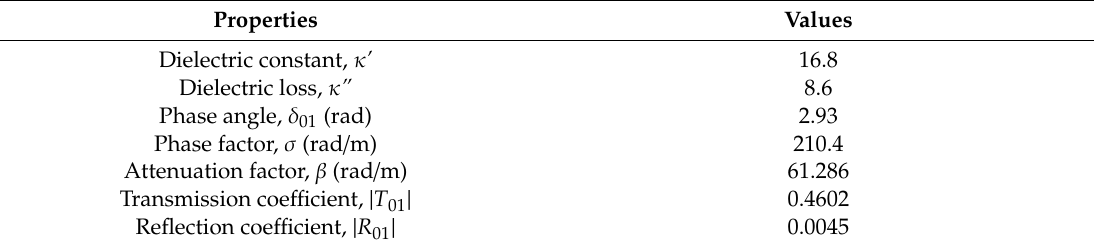
Table 3. Dielectric and material properties of ilmenite ( f = 2450 MHz) [30,31].